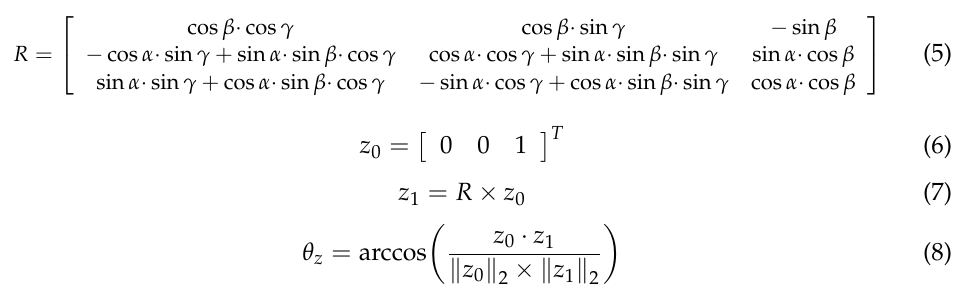
is set to , while the velocity ε 90° δ